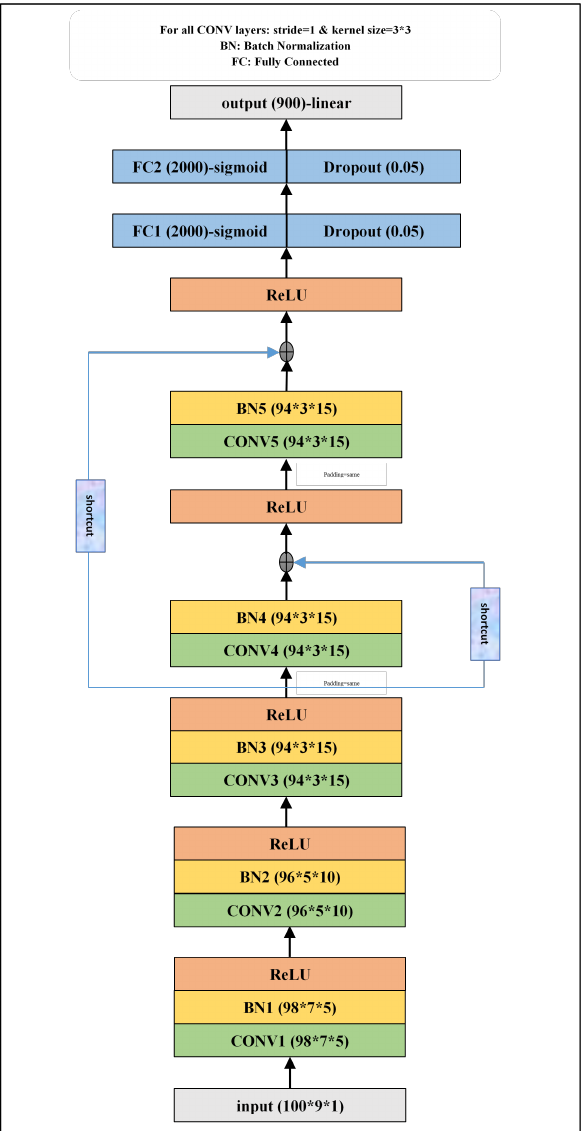
Figure 2. Structure of the skip connection-based CNN model developed in this